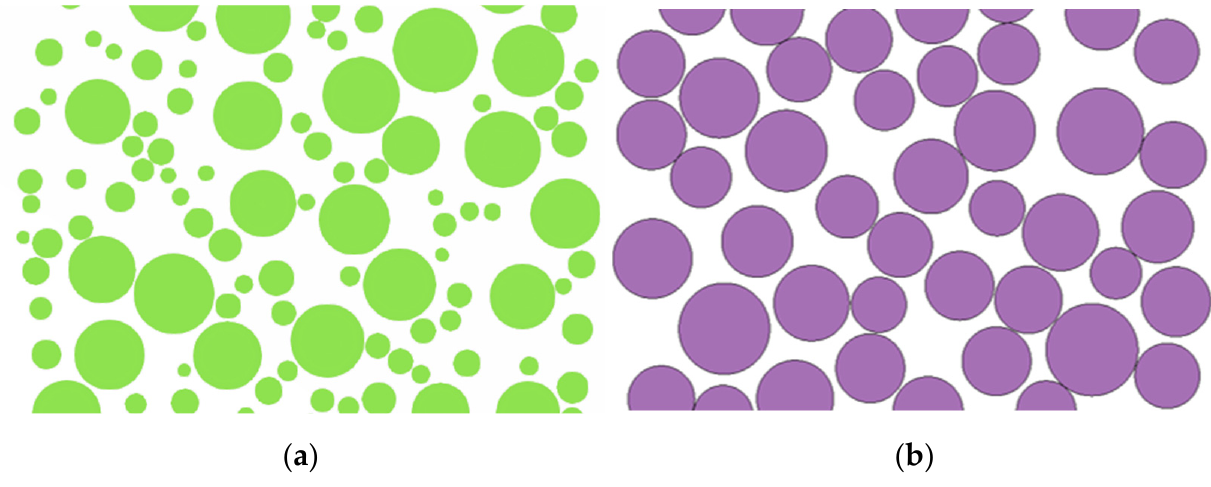
Figure 7. Industrial shot mix ( a ) and S460 brand-new shots ( b ).